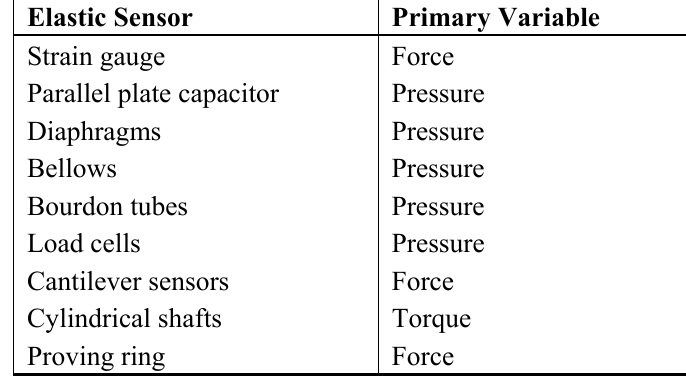
Table 1. Example of elastic sensors producing submtre displacement as output